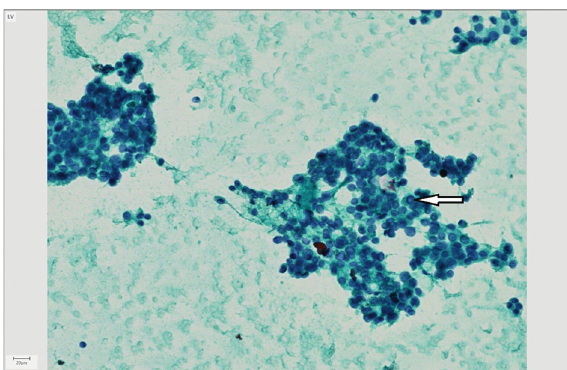
Figure 3: FNA of right neck mass shows cohesive nests of neoplastic thyroid tissue with overlapping nuclei and nuclear pleomorphism. The absence of colloid and macrophages is noted, and a subset of the cells shows nuclear pseudonuclear inclusions (arrow) supporting the diagnosis of papillary thyroid carcinoma (PAP stain,